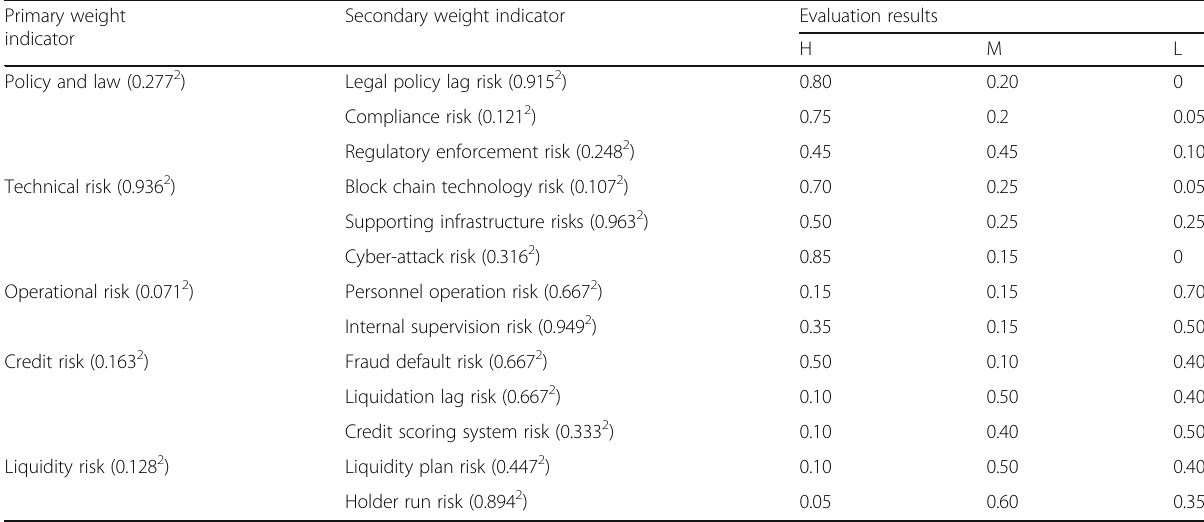
Table 4 Univariate evaluation result Primary weight